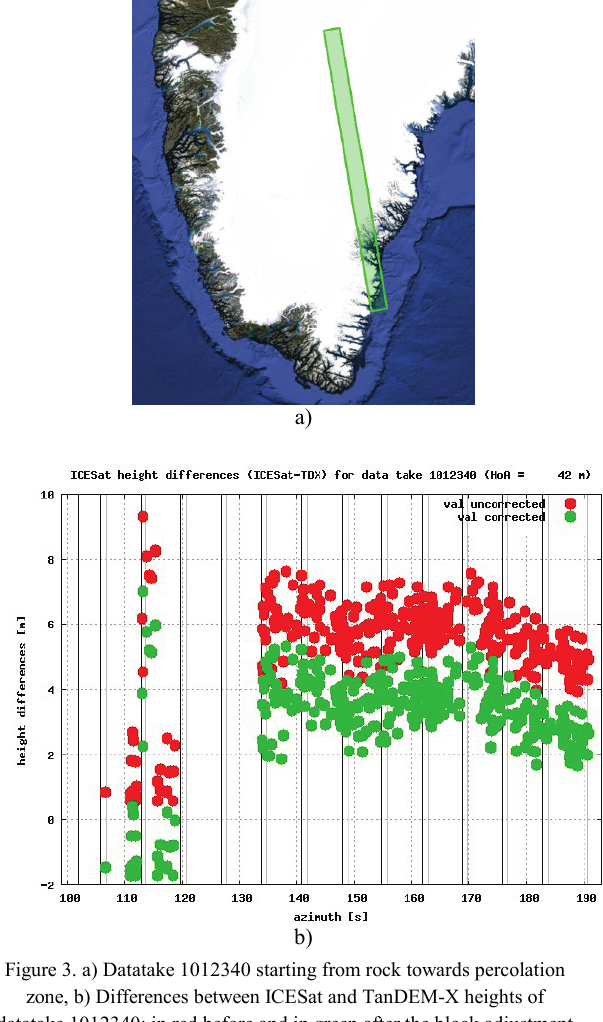
Figure 3. a) Datatake 1012340 starting from rock towards percolation zone, b) Differences between ICESat and TanDEM-X heights of datatake 1012340: in red before and in green after the block